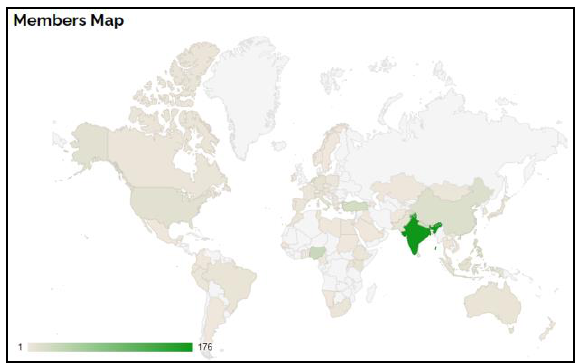
Figure 1. The members map of the ISPRS SC as of March 2022. The individual members are mostly from Asia and the Pacific, with India leading with a total of 176 members. A significant number of Consortium individual members also come from Nigeria (31), Turkey (22), Philippines (20) and China (16).